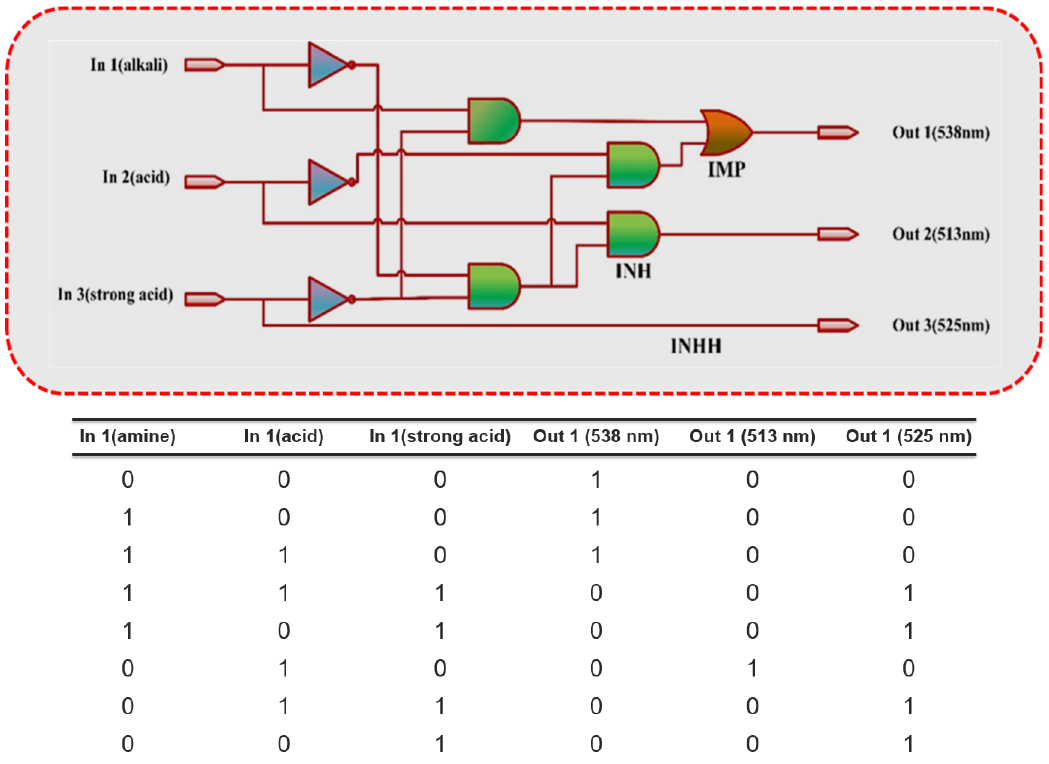
Figure 13. Colorimetric IMP , INH and INHH logic gates and their truth table basing on PI.